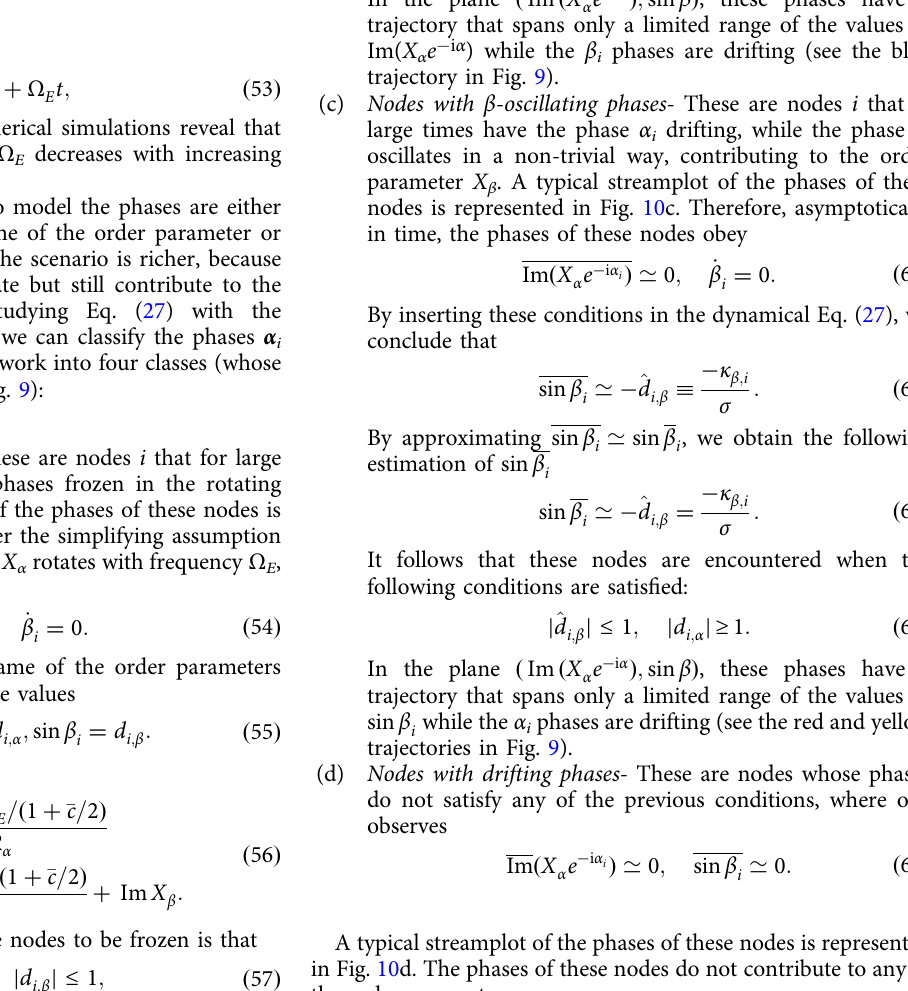
Fig. 9 Classi fi cation of nodes based on the trajectory of their phases. The trajectory of the ( α i , β i ) phases is shown in the plane ð Im ð X α e (cid:3) i α Þ ; sin β Þ for nodes with frozen phases (green and purple trajectories), for nodes with α - oscillating phases (blue trajectory) and nodes with β oscillating phases (red and yellow trajectories). Data are obtained from numerical simulation of Dirac synchronization in their backward transition for a value of the coupling constant σ = 1.77 and network size N =